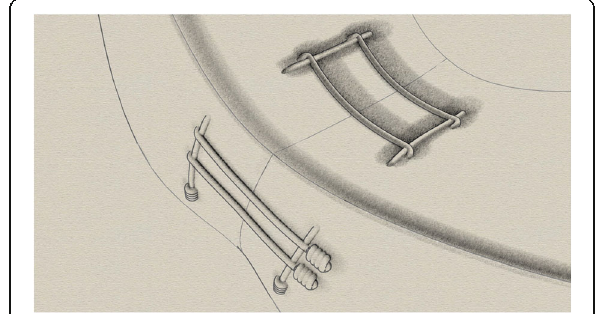
Fig. 2 Rebar Repair illustration. The 2 horizontal sutures are placed exactly juxtaposed to the vertical sutures. The horizontal sutures are running perpendicular to the radial meniscus